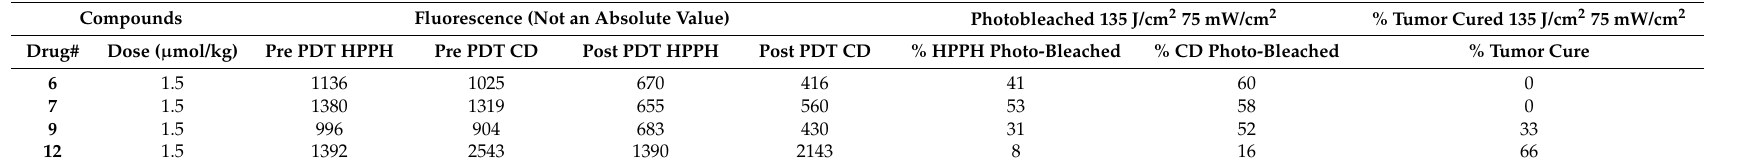
Table 3. Summary of the photobleaching of conjugates 6 , 7 , 9 and 12 at 135 J/cm 2 and 75 mW/cm 2